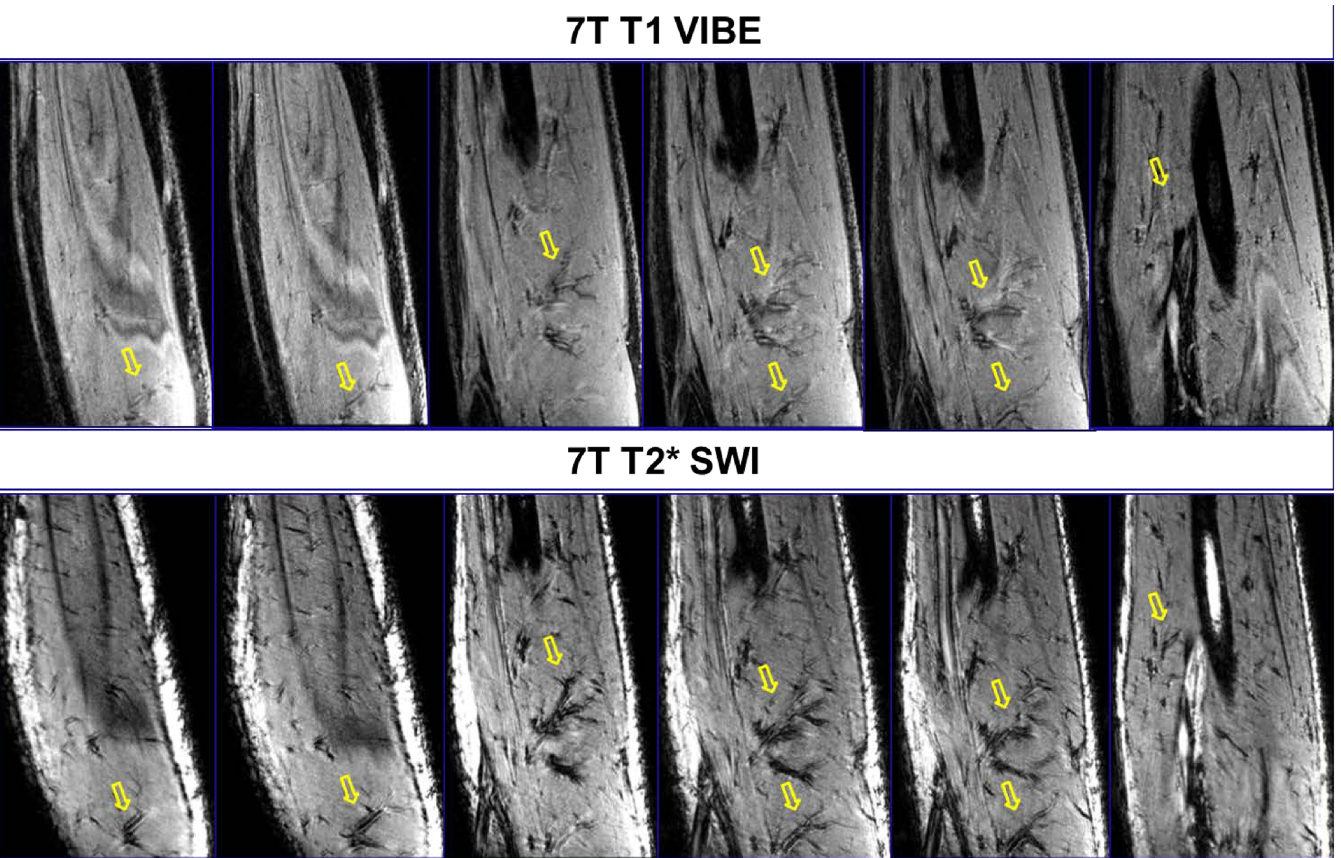
Fig 6. 7T T2 * SWI [bottom row] show marked enhancement of vascular patterns of arteries, veins and muscular perforators [marked with yellow arrow] when comparedto the T1 VIBE images [top row].